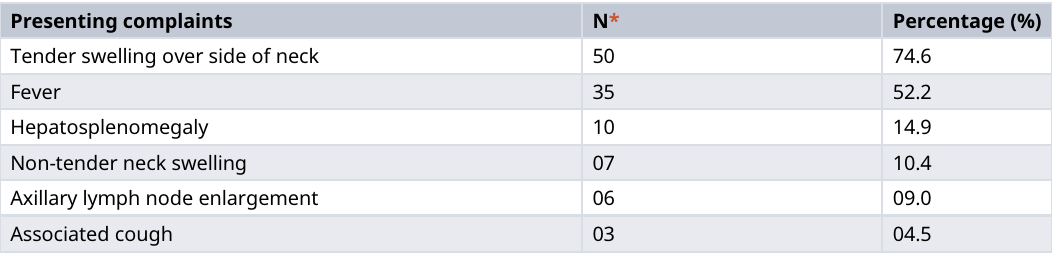
Table 2. Distribution pattern of the clinical presentation of KFD (n=67).